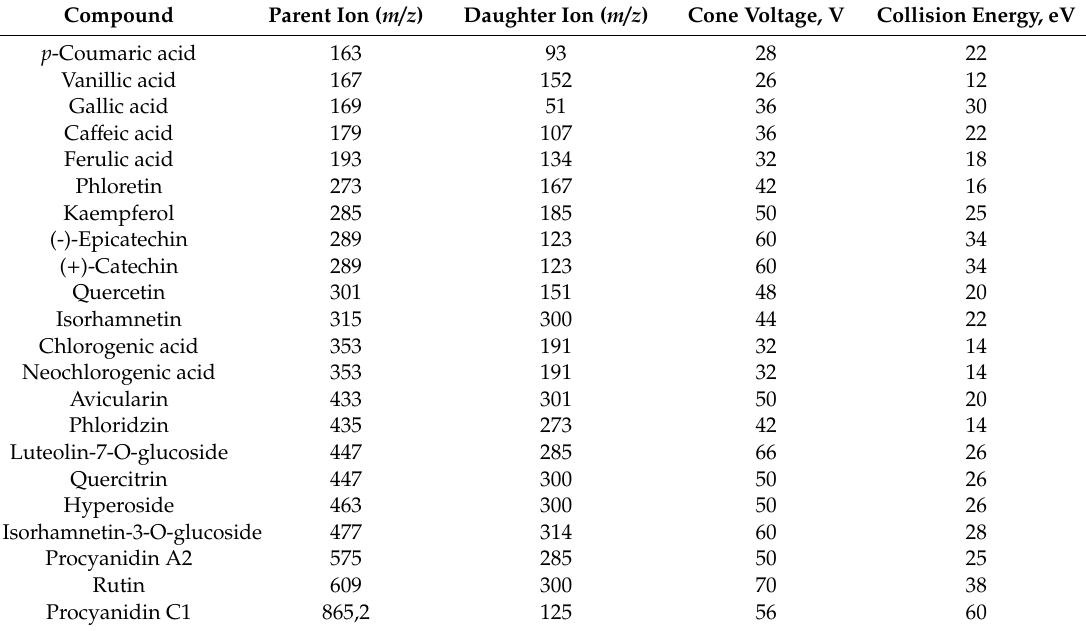
Table 2. Mass spectrometry parameters for the analysis of phenolic